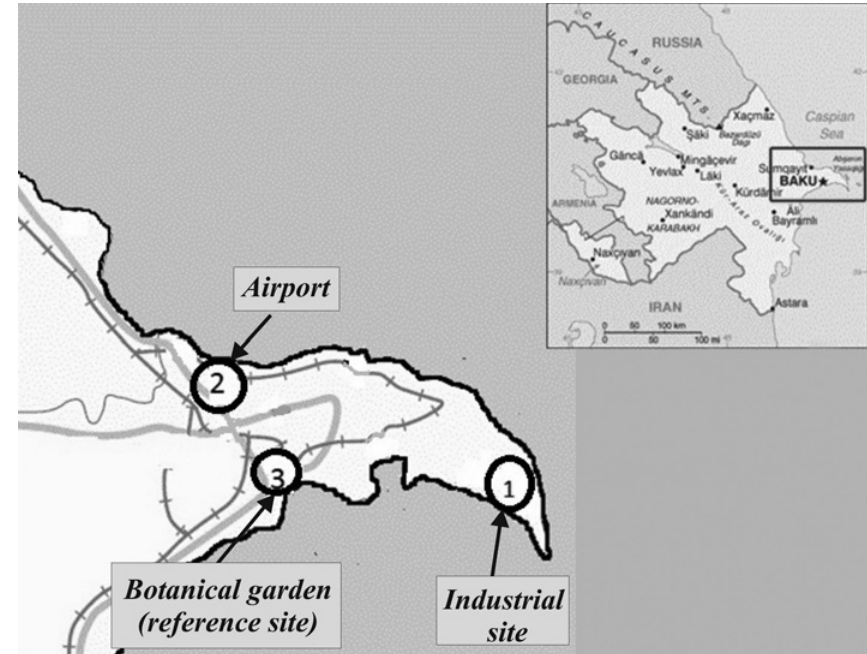
Fig. 1. Sampling locations of tree leaves in Baku,